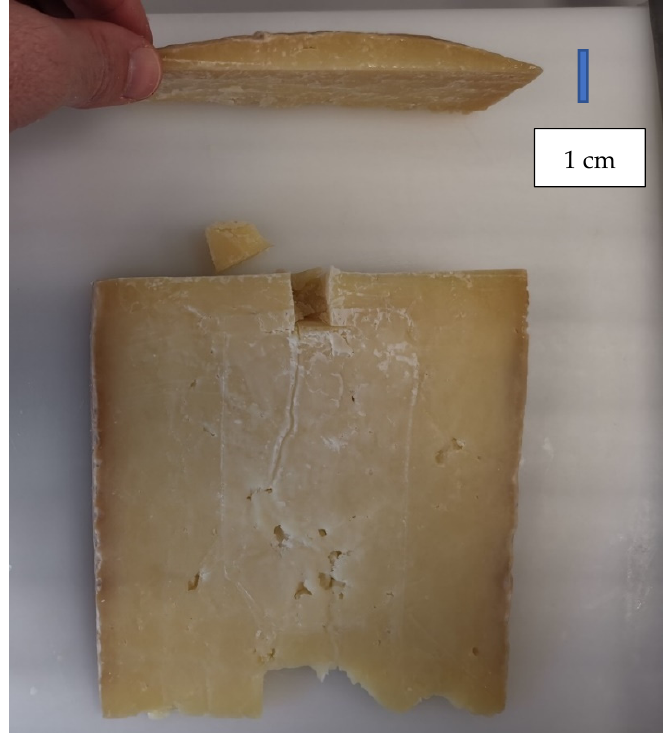
Figure 3. Cheese sample taken under the rind during the ALP analysis.